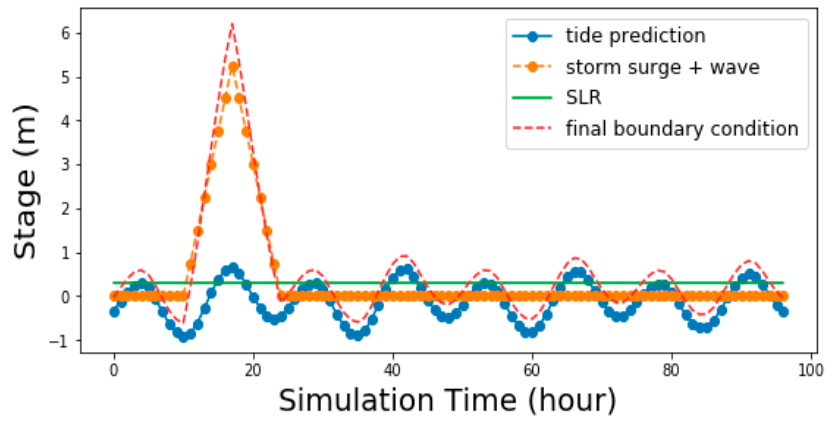
Figure 2. Coastal boundary condition with the tide, storm surge, wave, and future sea-level rise (SLR) corresponding to a 25-year event by the 2050s.